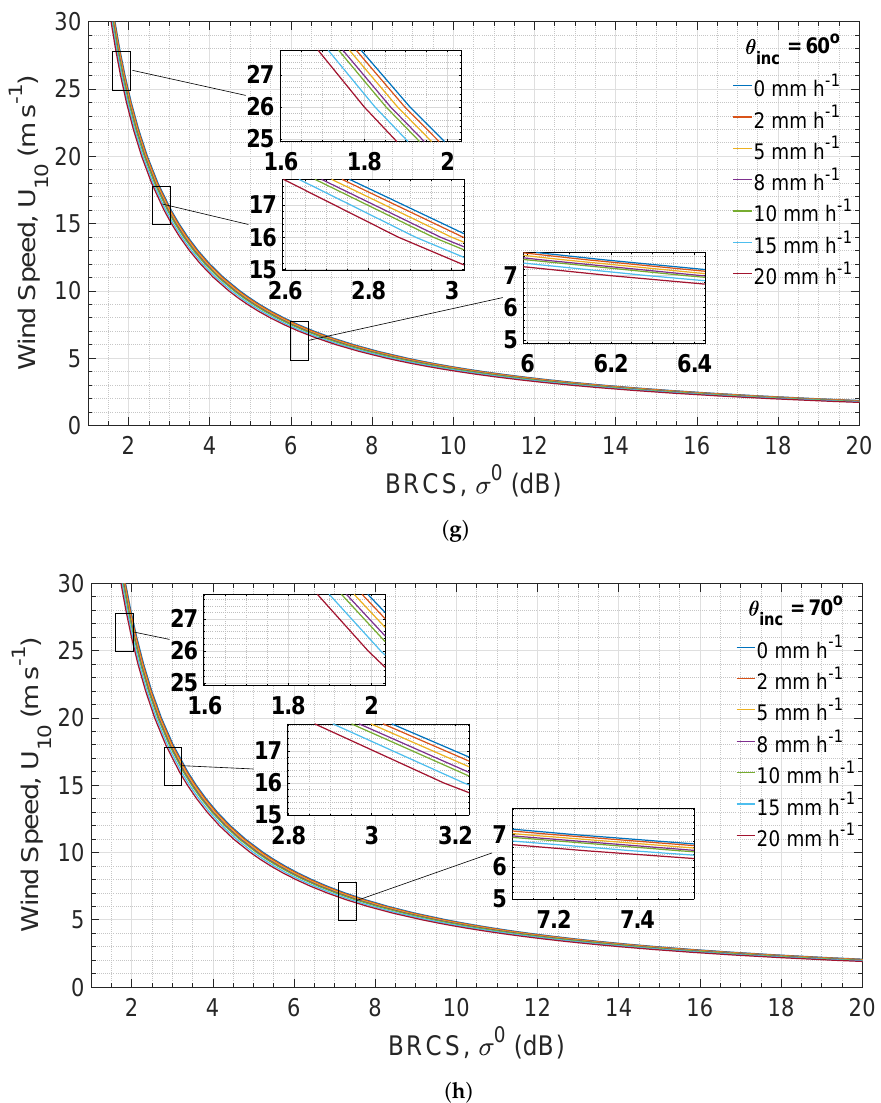
Figure 6. Rain attenuation effects on the Bistatic Radar Cross Section σ 0 at different rain rates and incidence angles of 0 ◦ ( a ), 10 ◦ ( b ), 20 ◦ ( c ), 30 ◦ ( d ), 40 ◦ ( e ), 50 ◦ ( f ), 60 ◦ ( g ), 70 ◦ ( h ).